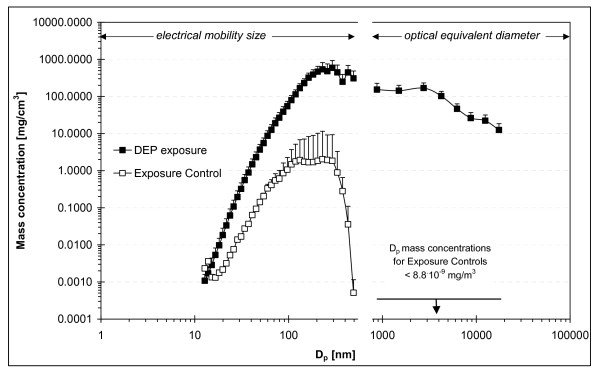
Average mass number distribution during DEP-exposure compared to the average mass distribution in exposure to controls.n = 26. Error bars denote the SD of the average concentrations calculated based on the average for each N exposure.